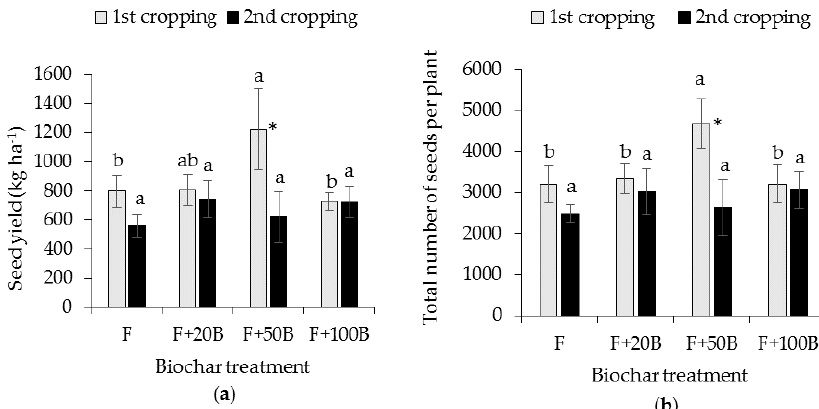
Figure 1. ( a ) The seed yield; ( b ) total number of seeds per plant as affected by rice husk biochar treatments. The bars represent the standard deviation of triplicates. Different lower case letters indicate significant difference ( p < 0.05) among treatment means. * Significant difference ( p < 0.05) between first and second cropping of the F+50B treatment.